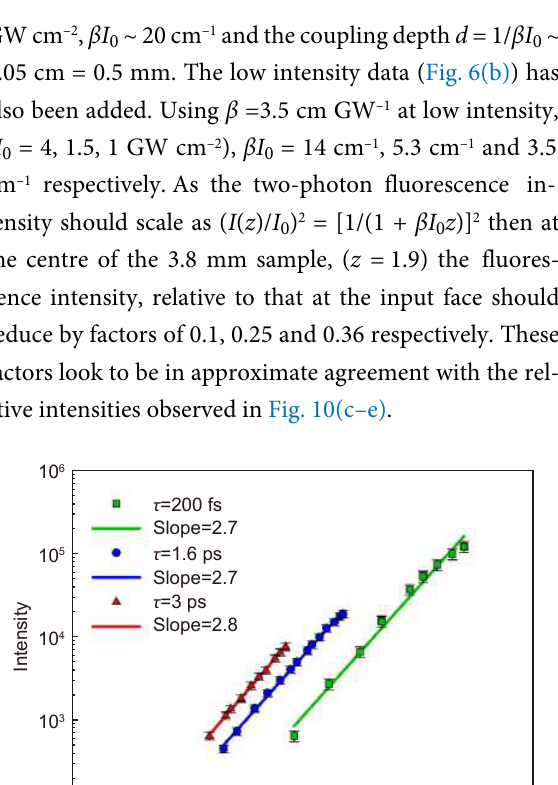
Fig. 8 | Front and rear side fluorescence spectra of 0.5 mm thick polycrystalline ZnSe. Peak wavelengths increase with incident intensity and rear side fluorescence shows evidence of self-absorption near the band edge.